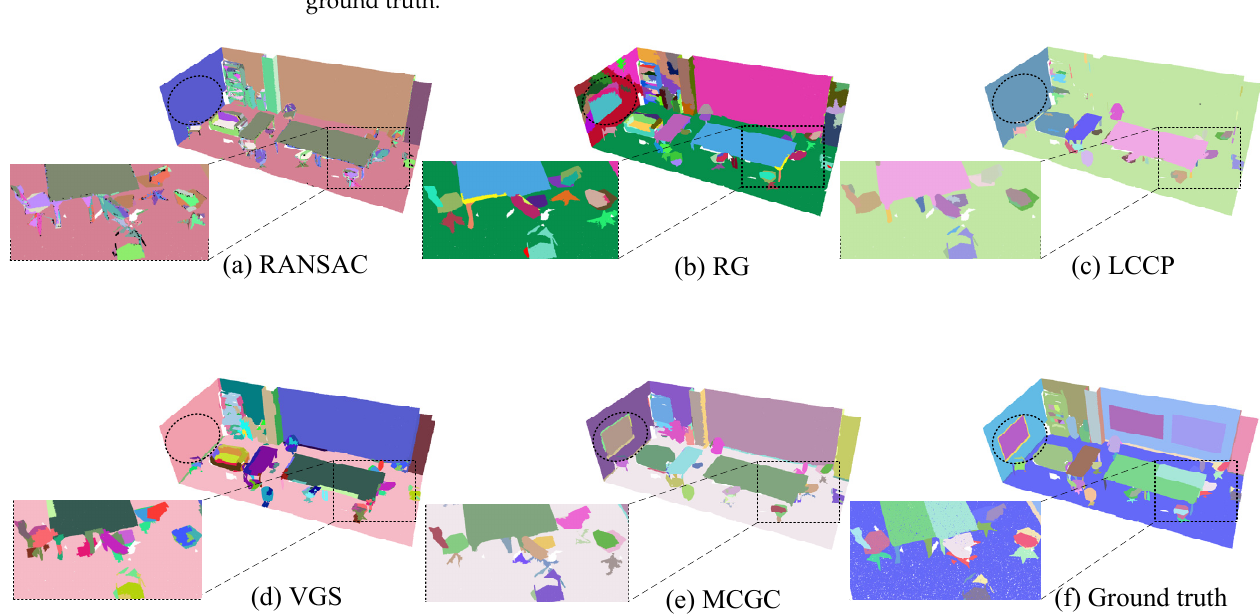
Figure 10. The visual comparison of the conference by different methods. One local scene slice which is selected to enlarge the segments in the black box. ( a ) The result from RANSAC. ( b ) The result from RG. ( c ) The result from LCCP. ( d ) The result from VGS. ( e ) The result from MCGC. ( f ) The ground truth.